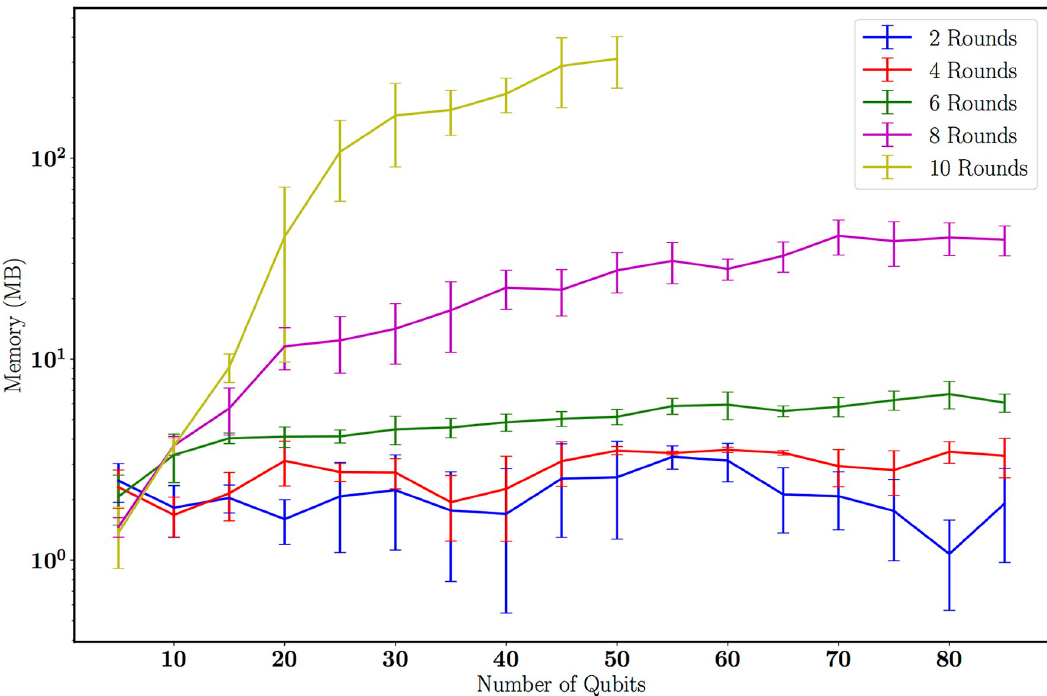
Fig 8. Memory usage as a function of the number of rounds (circuit depth) and with increasing number of qubits. Memory usage is constant for a small number of rounds but rapidly increases as the total circuit depth and number of qubits increases.